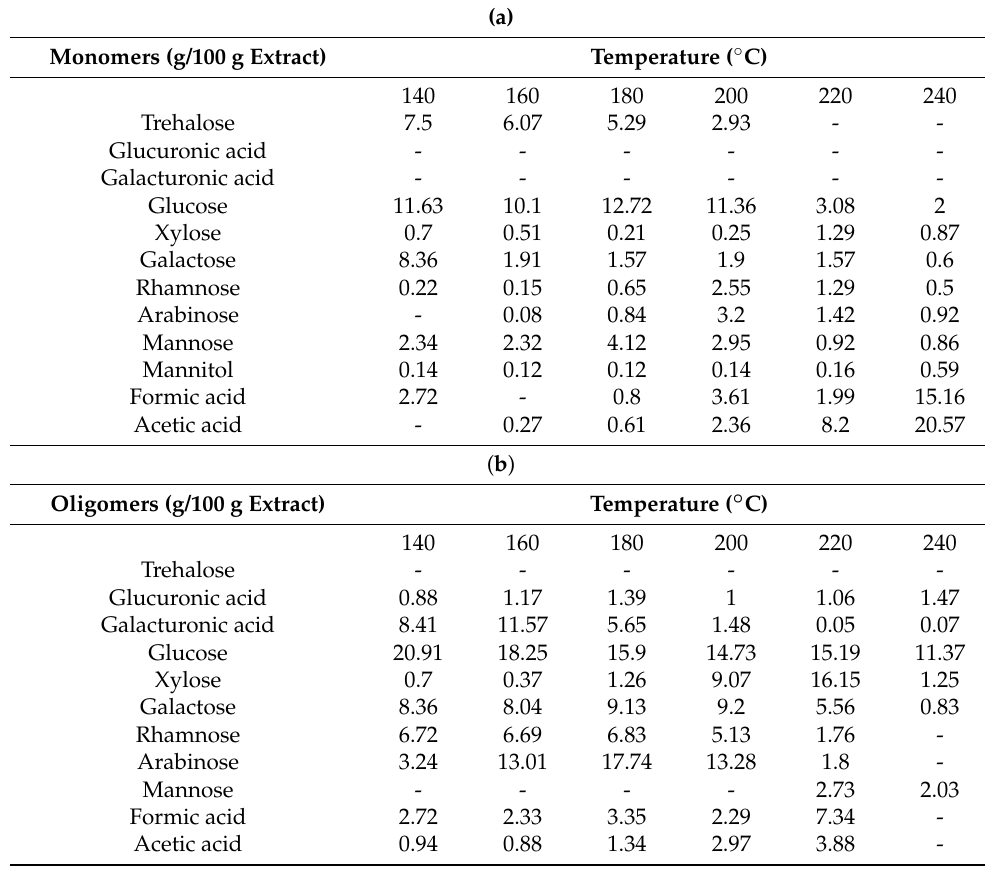
Table 2. Influence of the final extraction temperature on monomers ( a ) and oligomers ( b ) from saccharidic fraction of subcritical water extraction of Paulownia bark . (a) Monomers (g/100 g Extract)